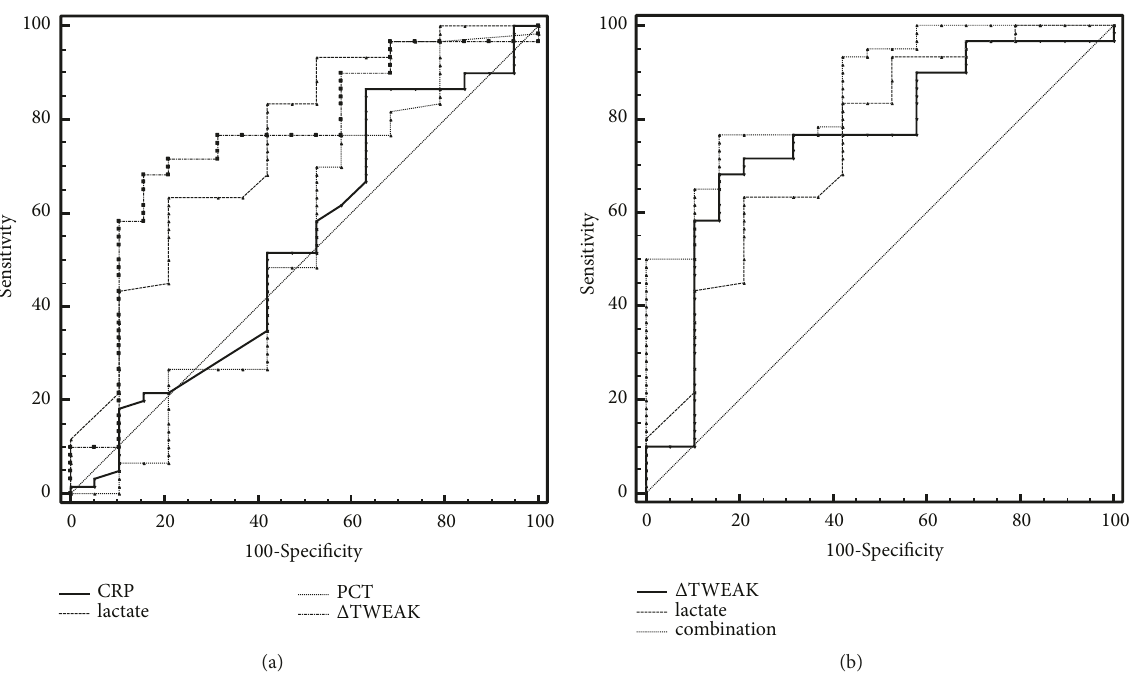
Figure 3: ROC curves comparing the diagnostic performances of: (a) C-reactive protein (CRP), procalcitonin, lactate, and Δ TWEAK concentrations for 28-day mortality. (b) Lactate, Δ TWEAK concentrations, and combinative index ( Δ TWEAK concentrations and lactate) for 28-day